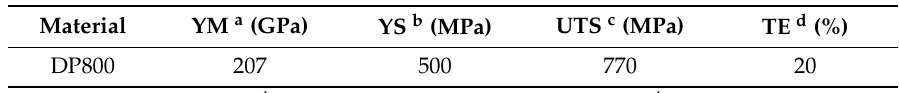
Table 2. Mechanical properties of DP800